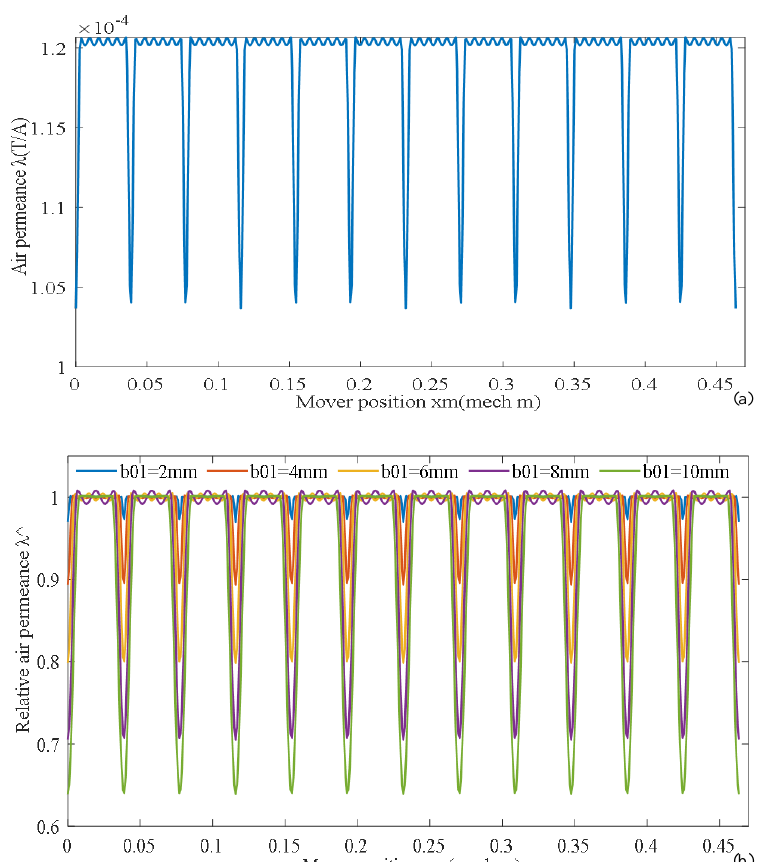
Figure 18. Air permeance function and relative air permeance function. ( a ) Air permeance function, ( b ) relative air permeance with slotting opening width b 01.